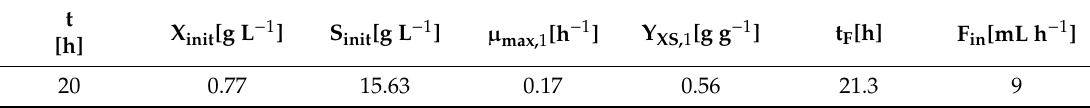
Table A17. Estimated initial concentrations for biomass X init and glucose S init and estimated model parameters for the maximum specific growth rate biomass µ max and yield coe ffi cient biomass / substrate Y XS at process timepoint t. Calculated glucose drop time at t F and calculated optimized feed rate F in for timepoint t F .